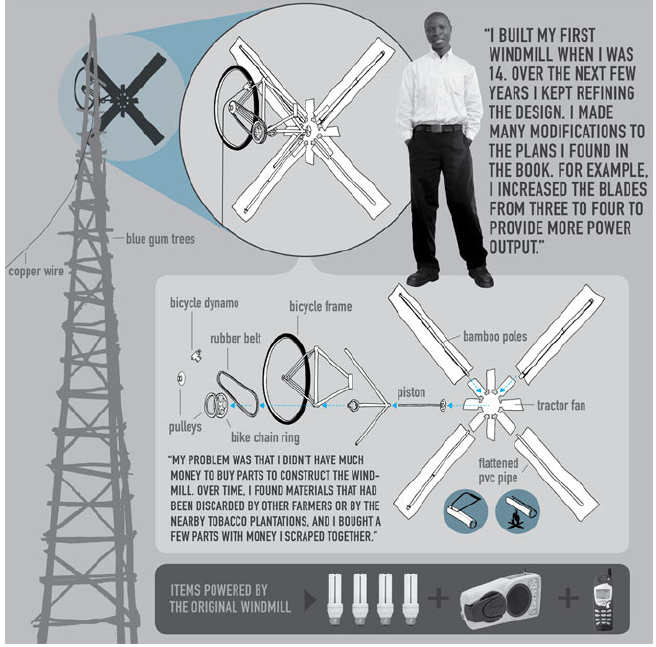
Figure 3. William Kamkwamba’s windmill design and components [24].